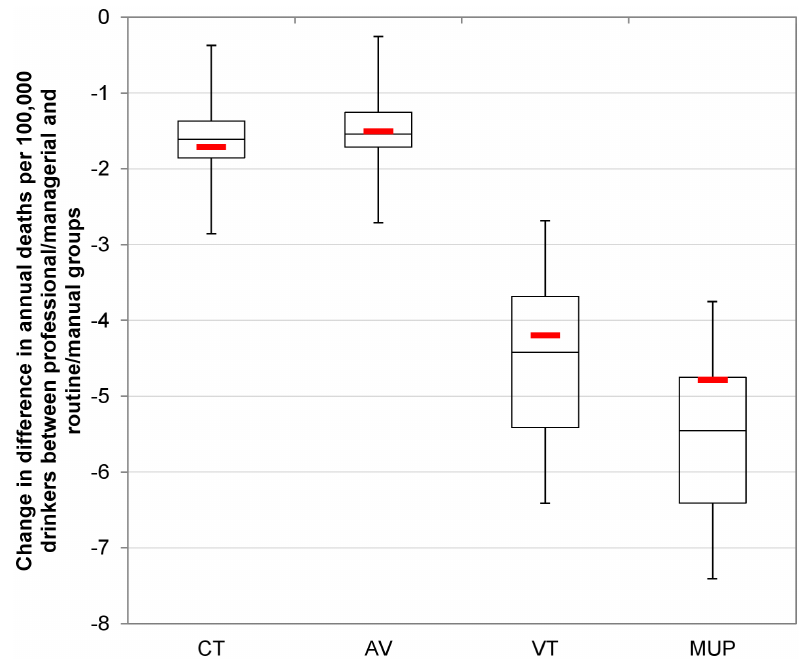
Fig 6. Probabilistic sensitivity analysis results for policy impacts on health inequalities. This figure shows PSA results for policy impacts on the equity gap in alcohol-related death rates between the routine/ manual and professional/managerial occupation groups. The overall plot represents uncertainty generated from 30 PSA runs. Whiskers represent maximum and minimum values. Boxes represent interquartile ranges. Mid-box lines represent medians. Red lines represent the baseline (deterministic) results. AV, ad valorem tax; CT, current tax increase; MUP, minimum unit pricing; VT, volumetric